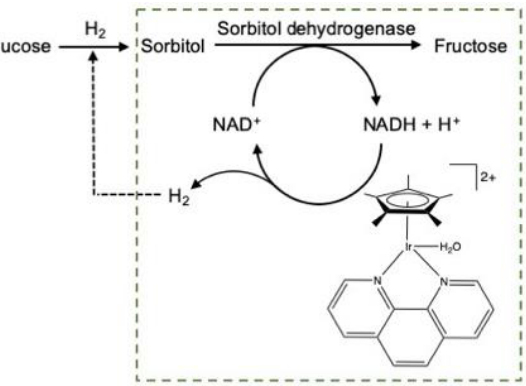
Figure 17. General concept of hybrid catalytic conversion of d-glucose into d-fructose using an irid- ium complex for NAD+ regeneration.